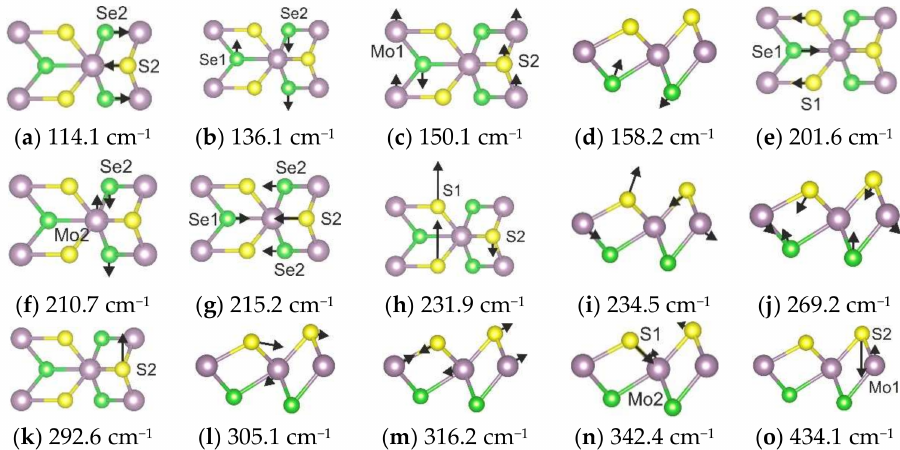
Figure 6. Schematic representations of the eigenvectors corresponding to the calculated vibrational modes of 1T’-MoSSe